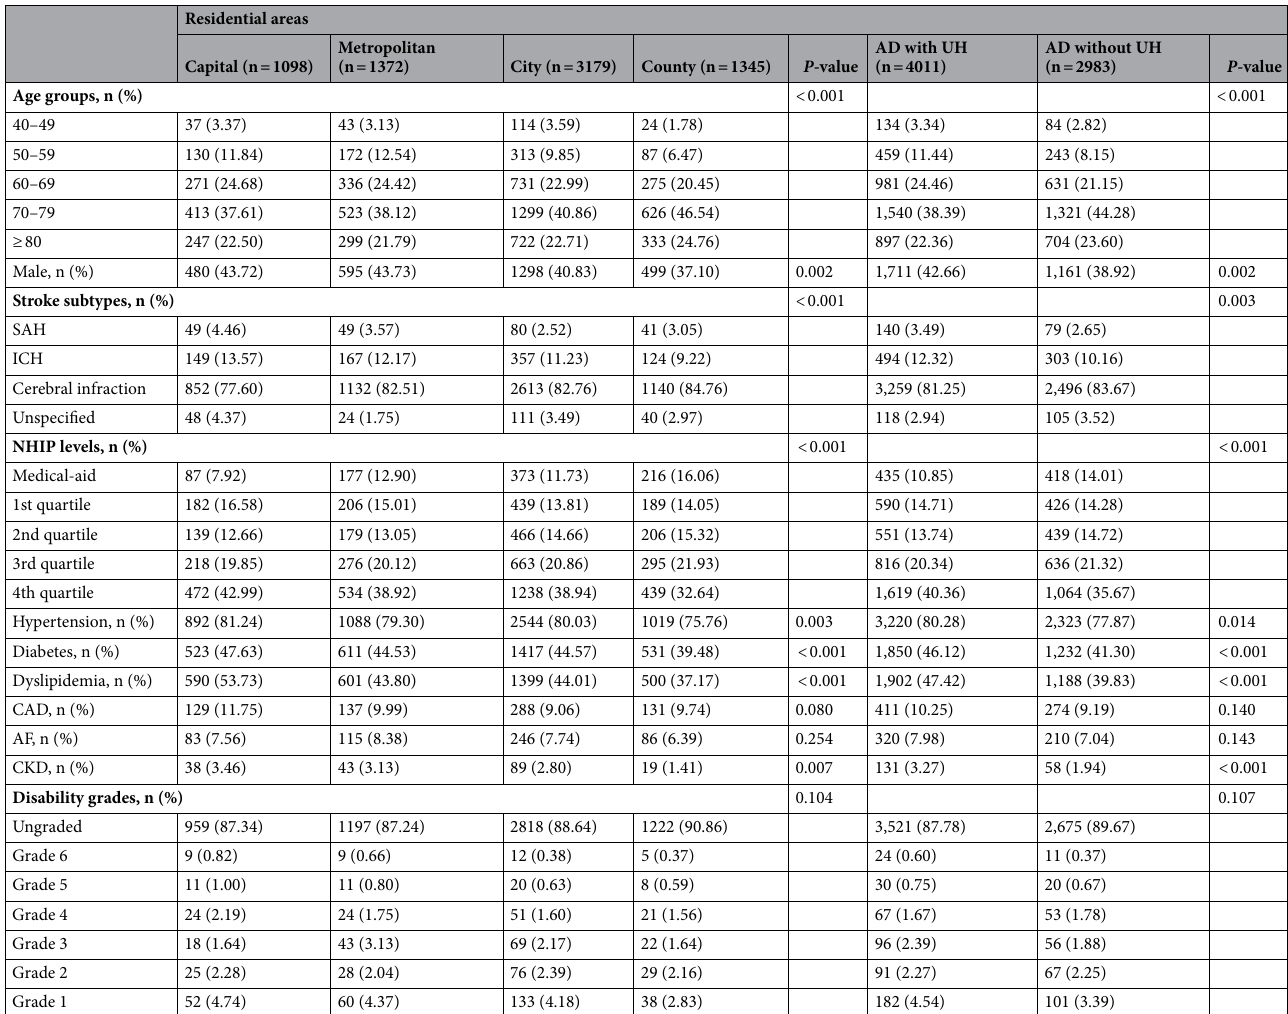
Table 2. Baseline characteristics according to the residential areas. AD administrative districts, UH university hospital, SAH subarachnoid hemorrhage, ICH intracranial hemorrhage, NHIP national health insurance premium, CAD coronary artery disease, AF atrial flutter/fibrillation, CKD chronic kidney